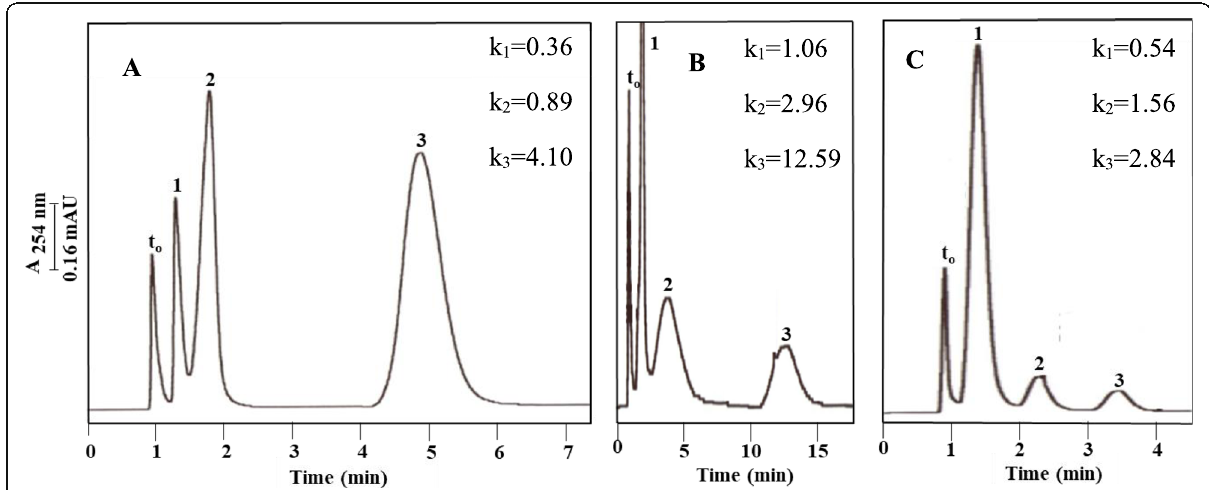
Fig. 8 Chromatograms of food additives ( a ), vitamins ( b ), and biological amines ( c ) obtained on 0.6 mg of CN-FSNPs/cm-poly(GMM-co-EDMA) column. For a and b , the conditions and the order of solute elution are the same as in Figs. 3a and b, respectively. For c , the conditions are the same as in Fig. 3c; solutes: 1, (±)-propranolol; 2, (±)-ephedrine; 3, (±)-phenylpropanolamine; t 0 ,